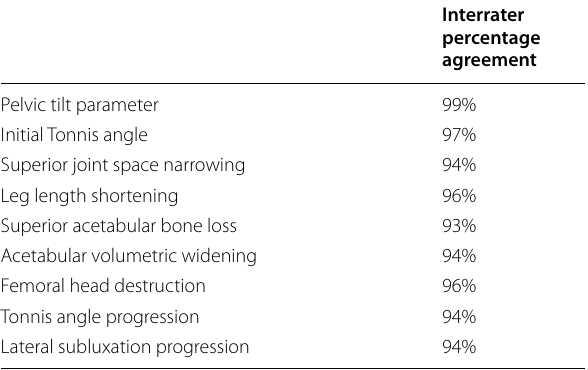
Table 5 Assessment of interrater reliability based on the RPOA diagnostic